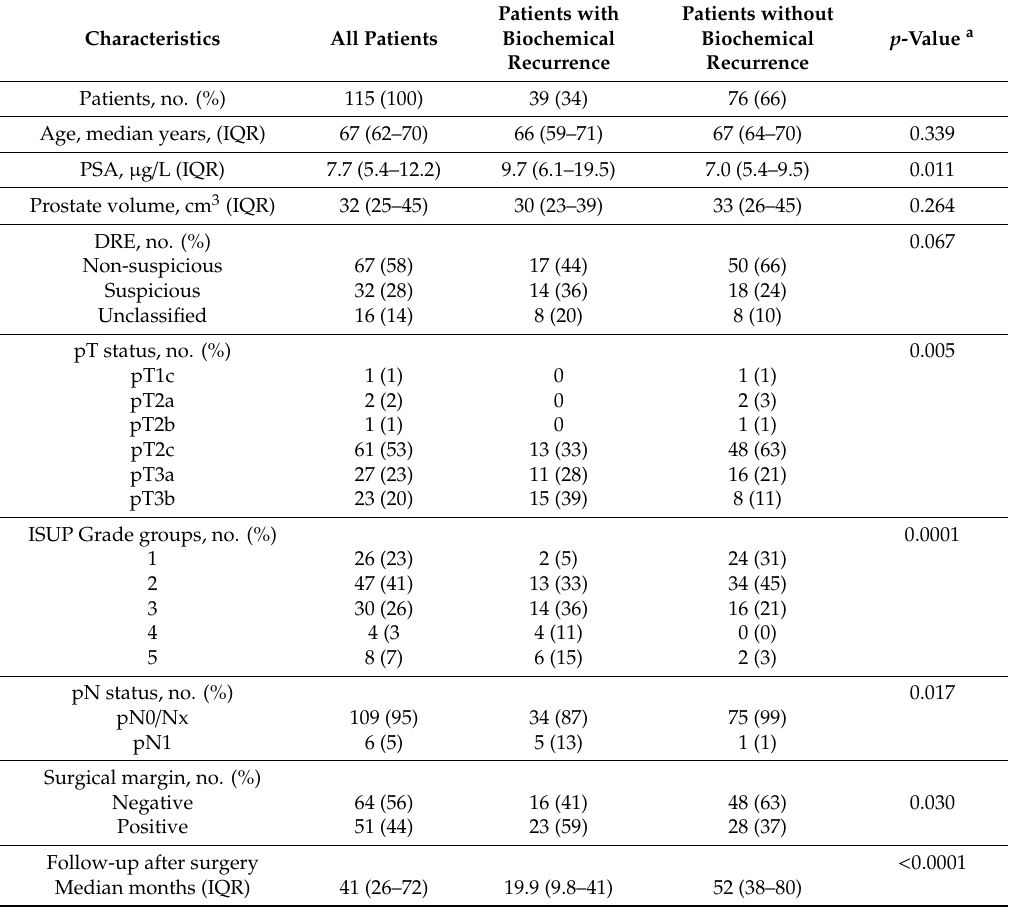
Table 1. Clinicopathological characteristics of the study